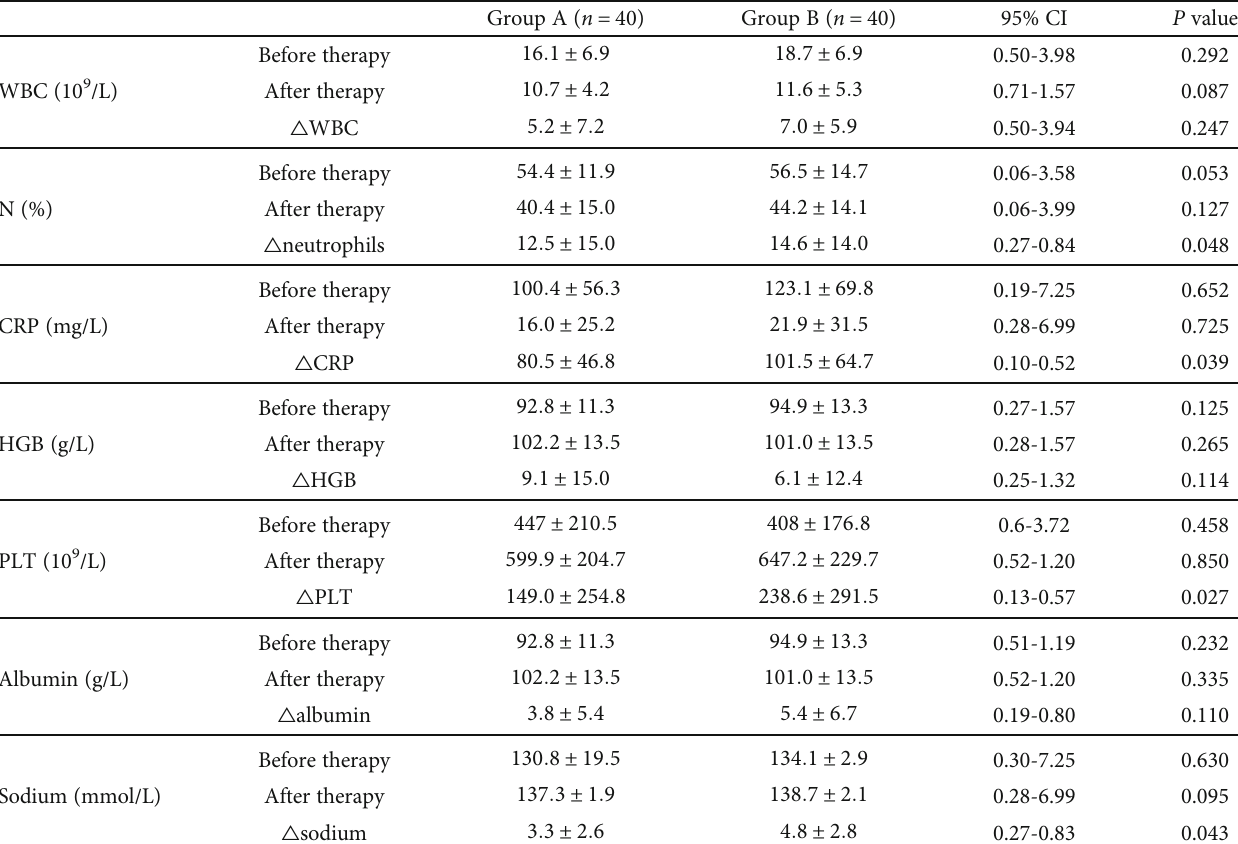
Table 2: Laboratory data on additional treatment.